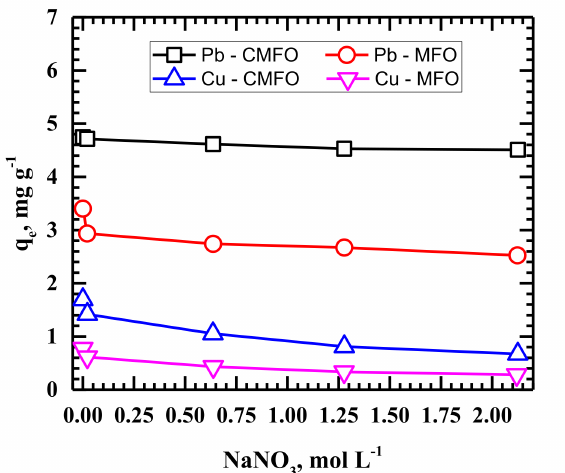
Figure 7. Effect of salt concentration on the uptake of Cu(II) and Pb(II) by CMFO and